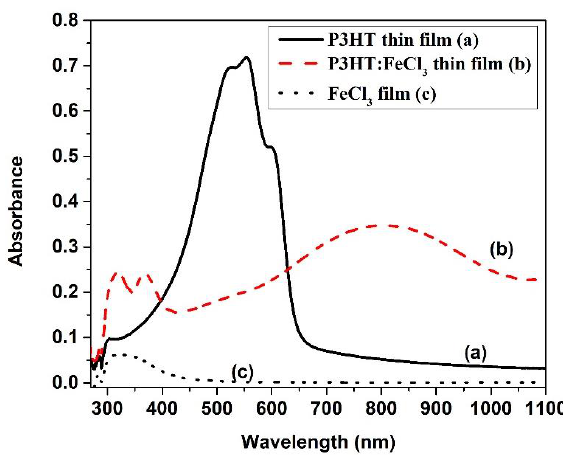
Figure 3. The absorption spectra.